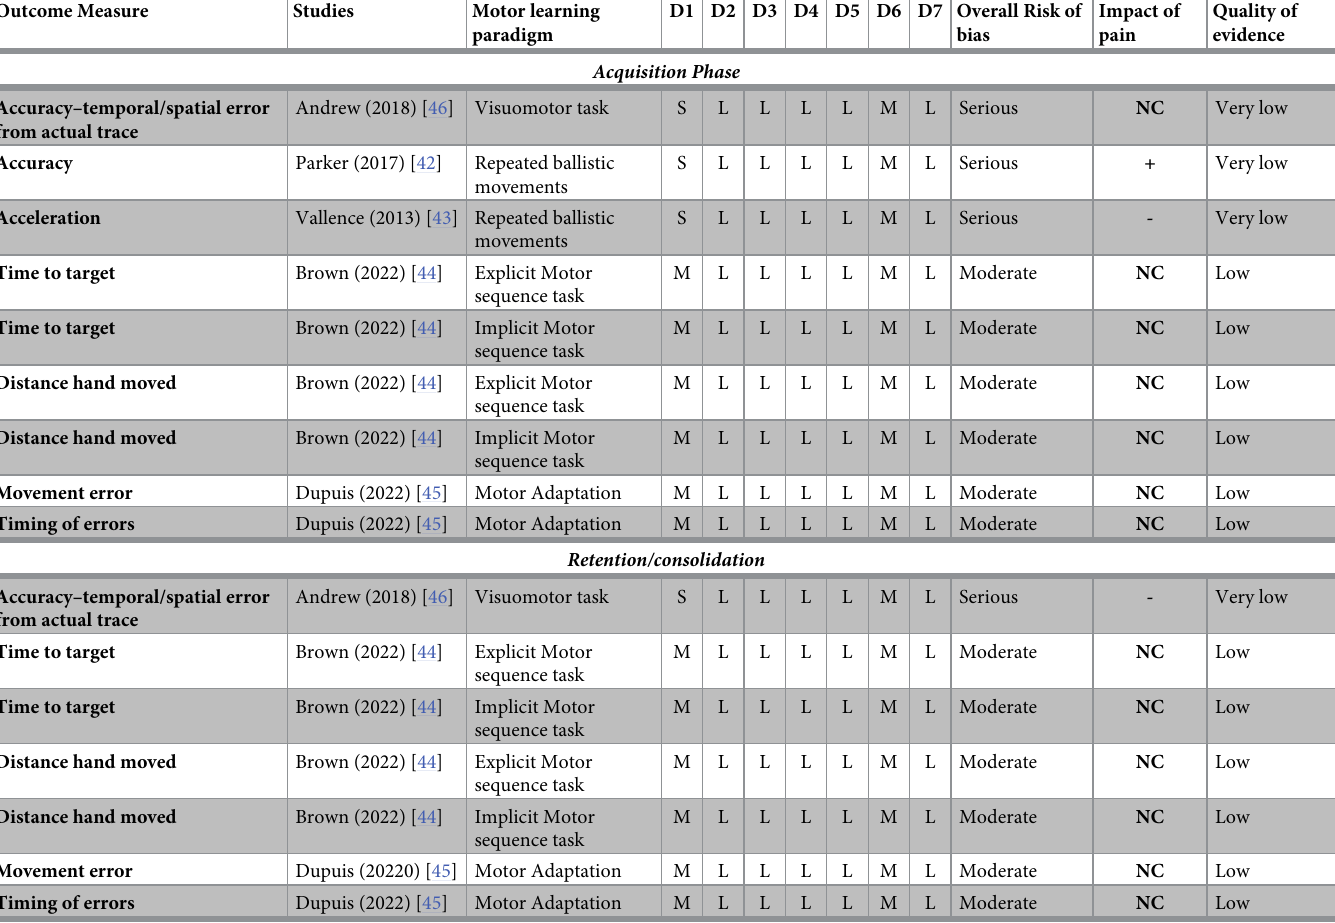
Table 6. Synthesis of evidence, risk of bias judgements and quality of evidence scores for the impact of clinical pain on individual task performance outcome